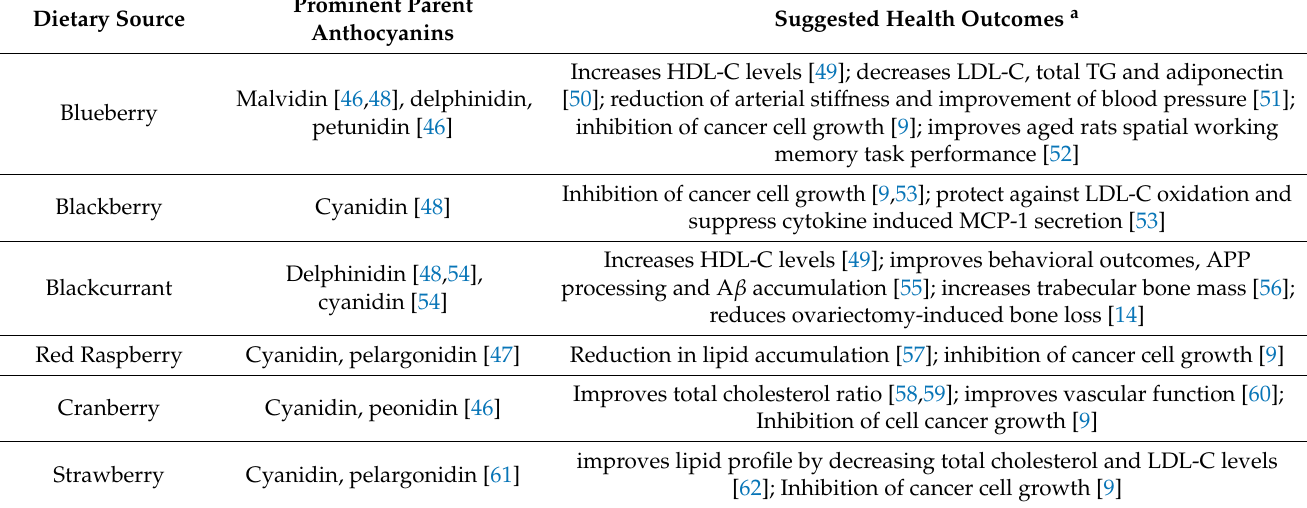
Table 1. Common dietary sources of anthocyanins and their documented health outcomes related to cardiovascular disease, cancer, neurodegenerative disorder and aging-associated bone loss. Dietary